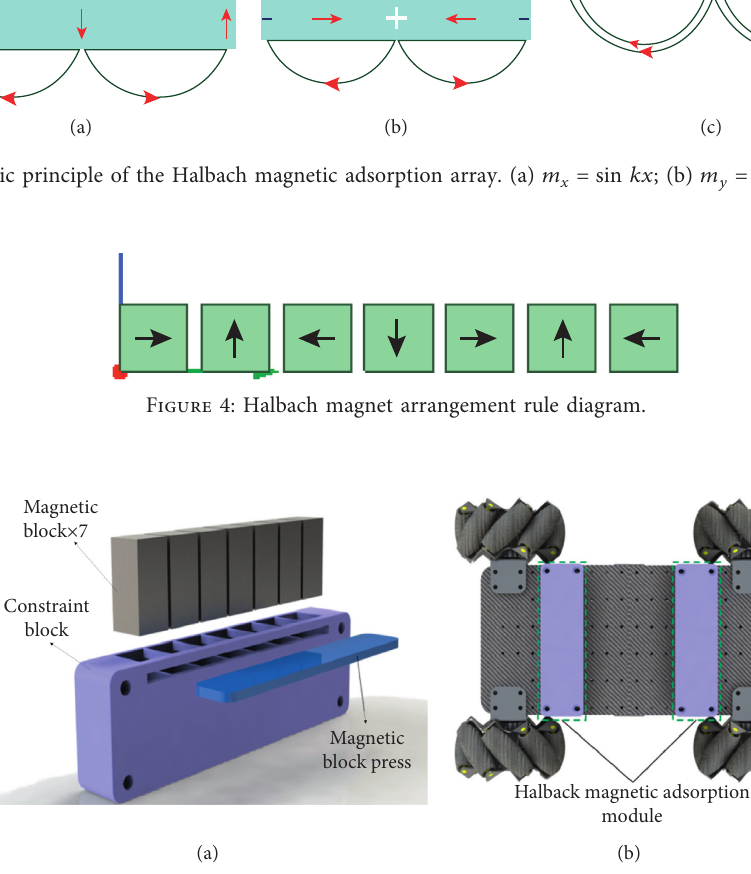
Figure 5: Magnetic array module. (a) Magnet installation structure illustration; (b) distribution of magnetic array on the